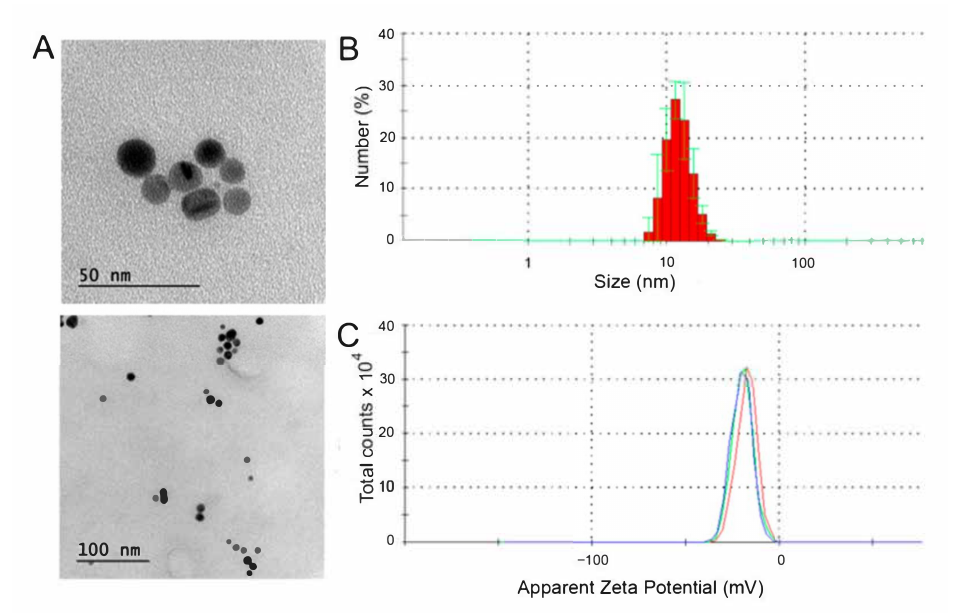
Figure 1. Characterization of the AgNPs: ( A ) TEM Micrographs; ( B ) Hydrodynamic size distribution; ( C ) ζ –potential.